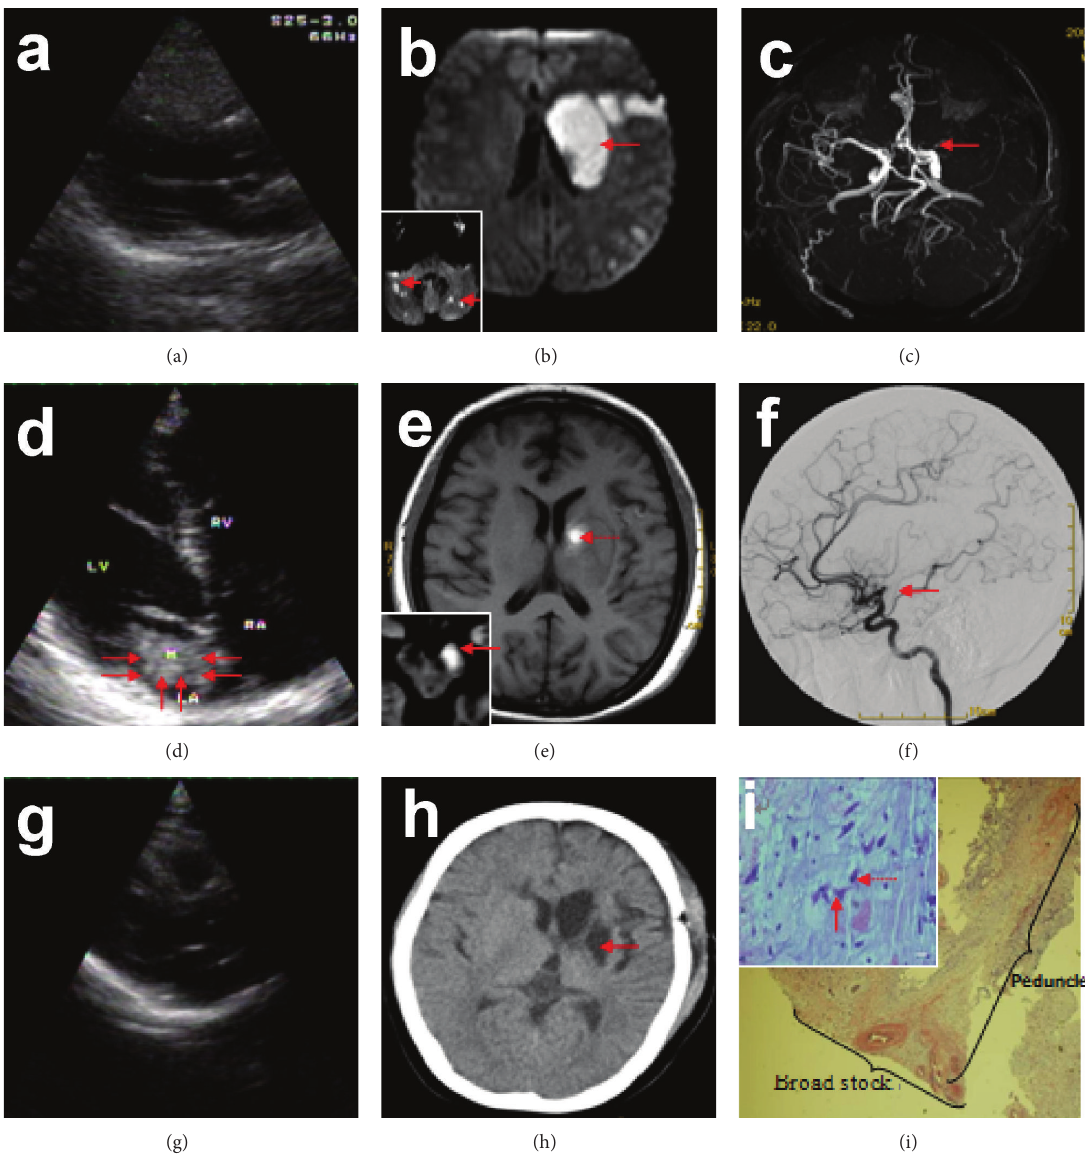
Figure 2: Patient presented with moyamoya disease. (a) Echocardiography with normal findings at the time of the first attack. (b) Brain MRI showed multiple new lesions in the left brain and bilateral cerebellum (arrow) at the first attack. (c) MRA revealed occlusion of the middle cerebral artery (arrow). (d) Echocardiography revealed a highly mobile mass attached to the fossa ovalis (arrow) at the second attack. (e) The second MRI showed a haematoma (dotted arrow) in the left basal ganglia and new infarction lesions in the left cerebral peduncle. (f) DSA showed occlusion of the middle cerebral artery (arrow) and secondary formation of an unusual vascular network (not shown). (g) After surgery, echocardiography showed that the mass in the left atrium had disappeared. (h) CT showed a stroke capsule in the left brain (arrow). (i) Histopathology showed spindle (dotted arrow) and stellate mesenchymal cells (arrow) that were embedded in the myxomatous